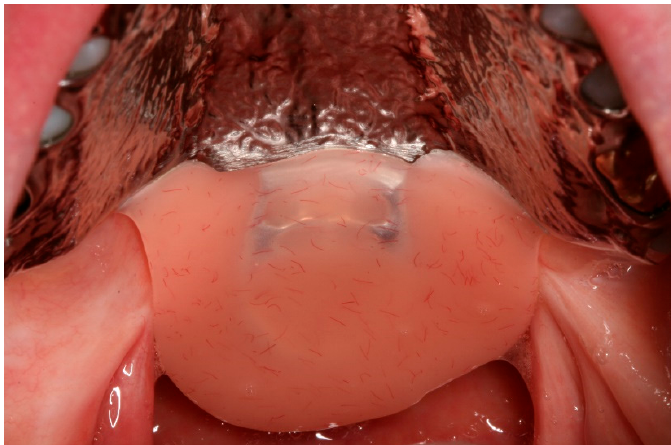
Figure 3. Intra-oral view showing the definitive prosthesis in-situ with good approximation of the lateral walls of the “bulb” to the soft tissues which help to provide a seal.